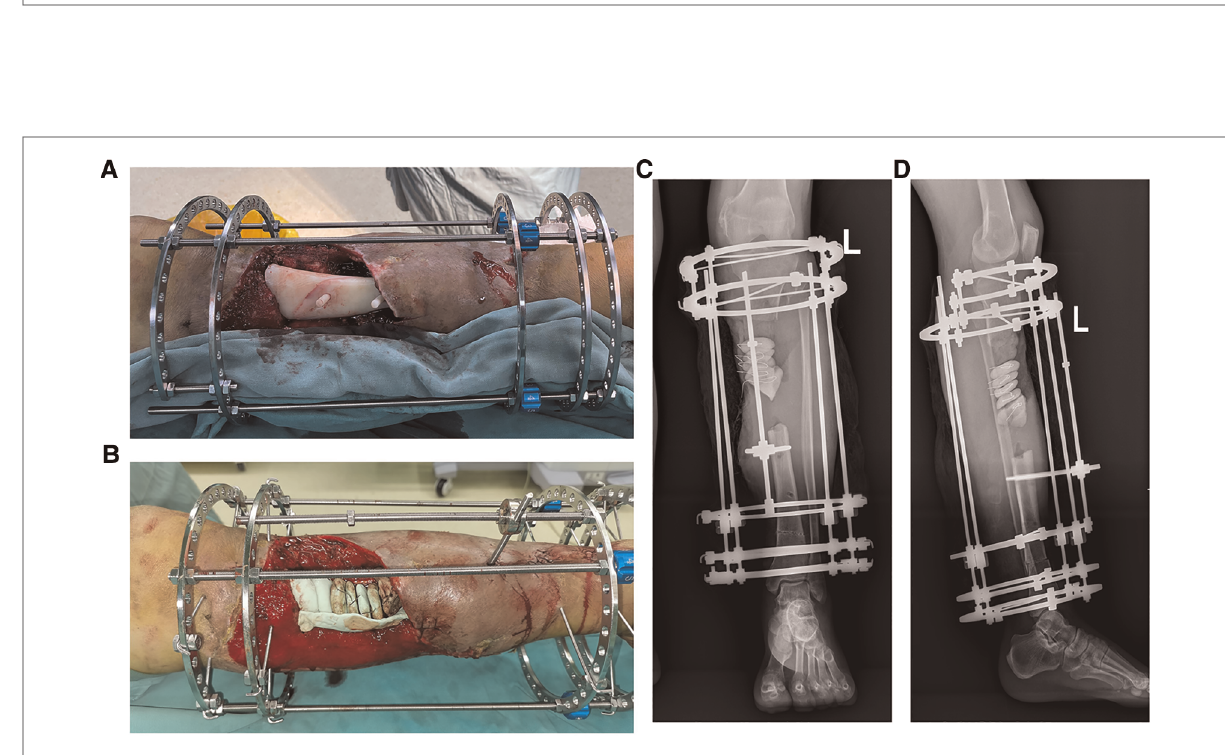
FIGURE 3 The design of PSI in case 1. ( A ) 3D bone model of affected limb in case 1, the length of bone defect is 144.0 mm. ( B ) 3D reconstruction of bone defect. ( C ) The design of PSI in case 1: (1) Handle. (2) Oblique dividing line. (3) Rod. (4) Rod hole. ( D ) 3D-printed PSI of case